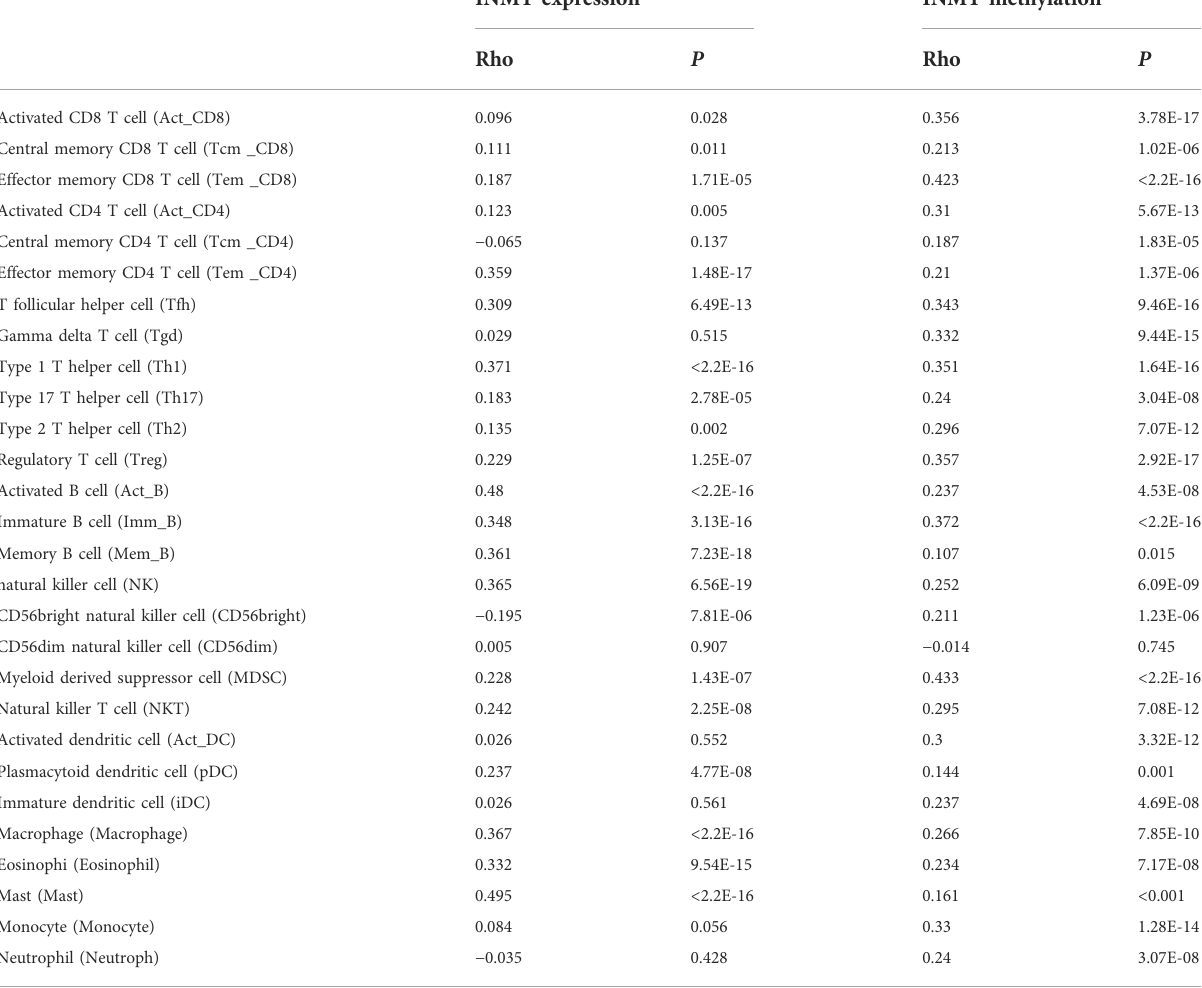
TABLE 2 Tumor lymphocyte in fi ltration in HNSC is related to INMT expression and methylation, respectively (TISIDB). INMT expression INMT